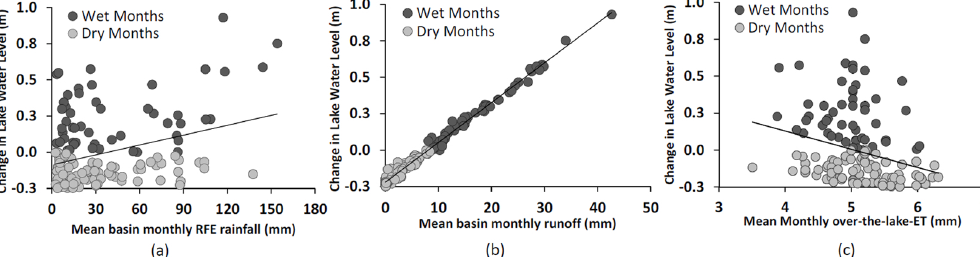
Fig. 5. Relationship between key model parameters and change in Lake Turkana water levels: (a) relationship between mean basin monthly RFE rainfall and change in lake water levels ( Y =0.0023 X − 0.0863); (b) relationship between mean monthly runoff and change in lake water levels ( Y =0.0273 X − 0.2205); and (c) effect of ET on change in lake water ( Y = − 0.1236 X +0.6231). All the trend lines and equations are derived using combined data (wet+dry months). Monthly data from 1998–2009 are used in this